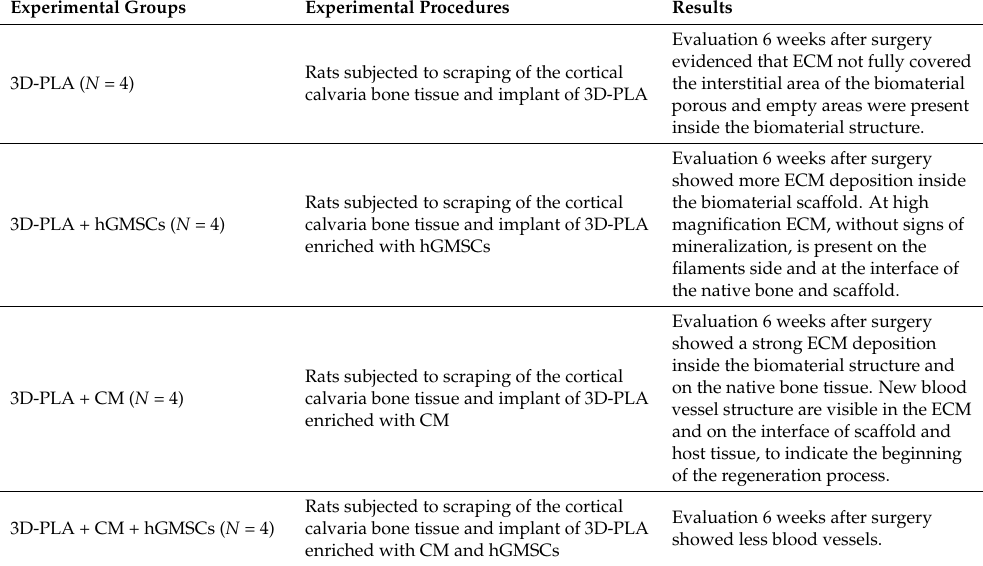
Figure 6. Histological examination of 3D-PLA + CM group and 3D-PLA + CM + hGMSCs group. Representative methylene blue and acid fuchsin images. ( A ) 3D-PLA + CM group at low magnification (4 × ); ( B ) 3D-PLA + CM group at high magnification (20 × ); ( C ) 3D-PLA + CM + hGMSCs group at low magnification (4 × ); ( D ) 3D-PLA + CM + hGMSCs group at high magnification (20 × ). *: 3D-PLA scaffold; C: rat calvaria. Scale bars represent 10 µ m. Table 2. Summary of in vivo findings of the different experimental groups.